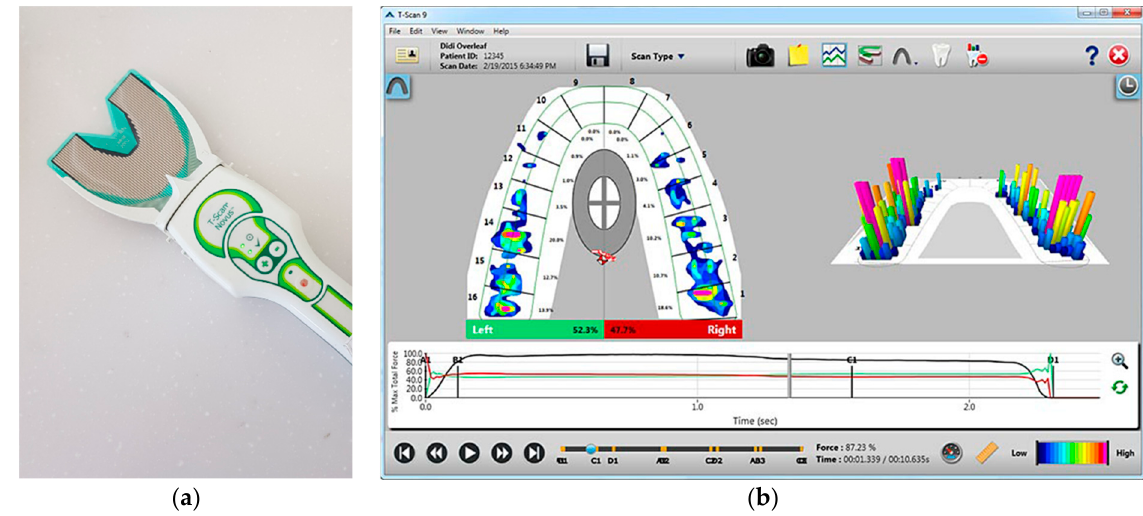
Figure 2. T-Scan system (T-Scan Novus system). ( a ) Scanner with a hand-held pressure-measuring sensor to be connected to a PC or notebook; ( b ) T-scan v10 software displaying the occlusal changes. As soon as the scan is completed, it is displayed on the screen, and the scan is positioned at the point of initial contact. The 2D force-view shows the distribution of occlusal contacts. While the green box shows a proportion of occlusal forces on the left side, the red box shows that on the right side. Occlusal forces and changes are displayed with a colored map according to the reference color scale on the lower right corner. The graph below shows the change of occlusal distribution based on time.